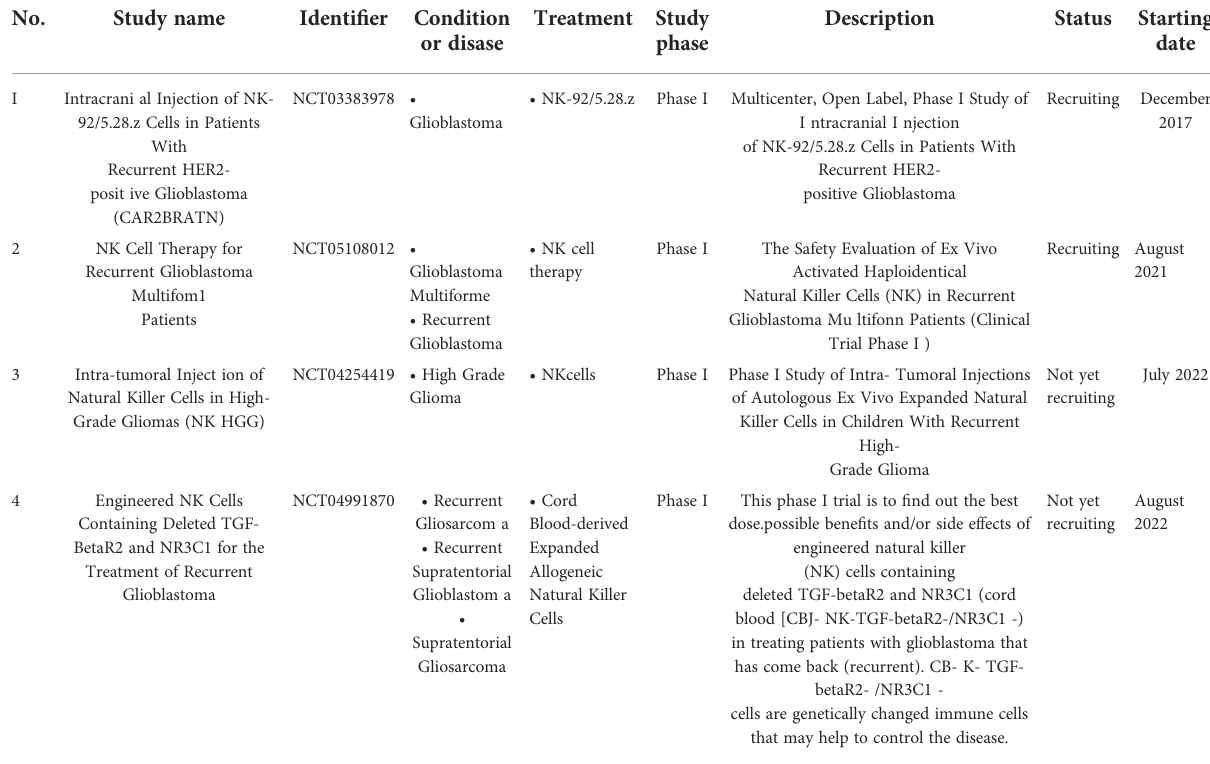
TABLE 2 List of completed and ongoing clinical trials of NK cell therapy on GBM was obtained from https://www.clinicaltrials.gov (keywords: glioblastoma and NK cells) until November 2022.